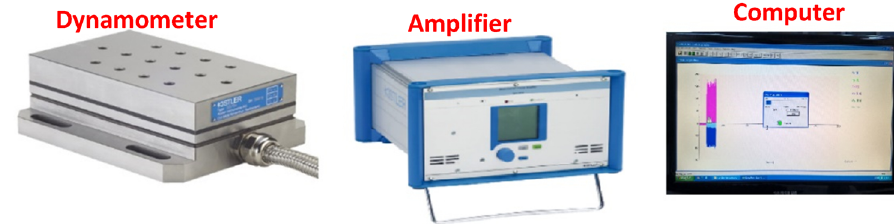
Figure 2: Cutting force measuring setup.